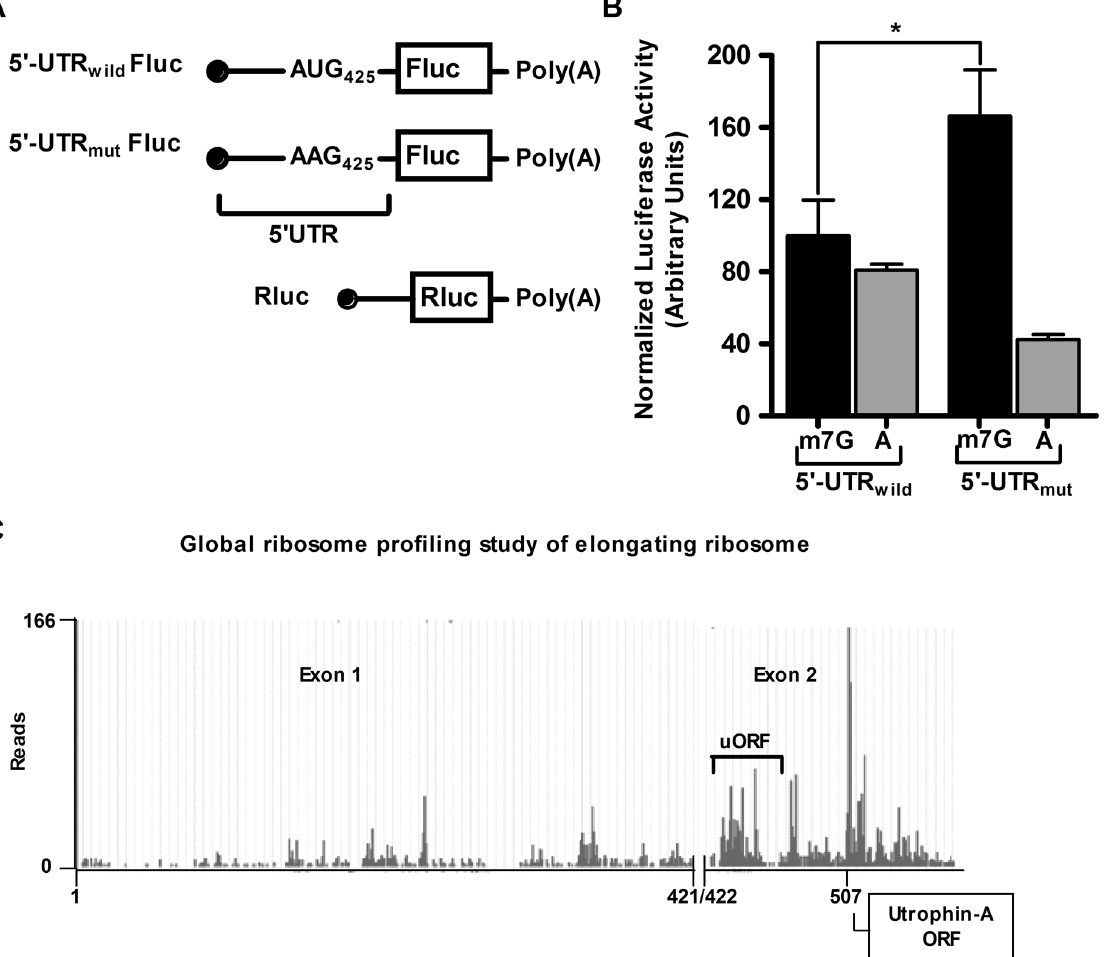
Fig 4. Role of upstream open reading frame on the utrophin-A 5'-UTR in m7G-cap-dependent translation. (A) Schematic presentation of monocistronic mRNAs used in the assay. Fluc: Firefly luciferase, Rluc: Renilla luciferase. To normalize activities of m7G and A-capped Fluc constructs containing the tested 5'-UTRs, the m7G-capped Rluc was used as reference. (B) Expression of m7G and A-capped monocistronic reporter transcripts with 5'- UTRwild and 5'-UTRmut were compared in the RNA transfection assay with mouse C2C12 cells. Upstream AUG in full length 5'-UTR (5'-UTRwild) was mutated to AAG425 in 5'-UTRmut. Results presented as mean ± SD (n = 6). Student ’ s t test was used to analyze the data. The asterisk denotes the statistically significant (P < 0.001) difference in normalized luciferase activity. (C) Results of global ribosome profiling study of elongating ribosome available at GWIPS-viz (http://gwips.ucc.ie) showed sufficient ribosome accumulation at upstream open reading frame (region 425 – 452 nt on utrophin-A 5'-UTR) as indicated by higher reads at this